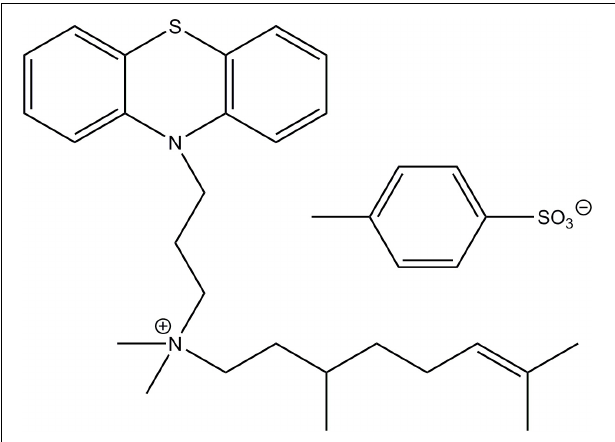
FIGURE 1 | The structure of JBC 1847 and its anion.